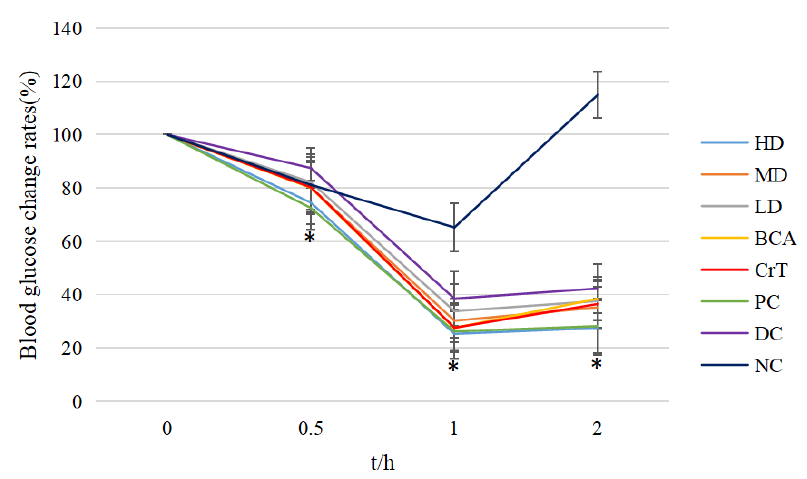
8 of 22 Figure 9. OGTT in each group of mice. Values are means ± SD ( n = 7). The differences between these groups and the DC group were statistically significant (denoted by “*” for p < 0.05). 2.2.6. Comparison of ITT Figure 10 shows the results of ITT in each group after 4 weeks of administration. The results of ITT in the HD and PC groups were better than that in the DC group after 0.5 h of insulin administration ( p < 0.05). The results of ITT in the HD, MD, BCA, CrT and PC groups were better than that in the DC group after 1 h of insulin administration ( p < 0.05).